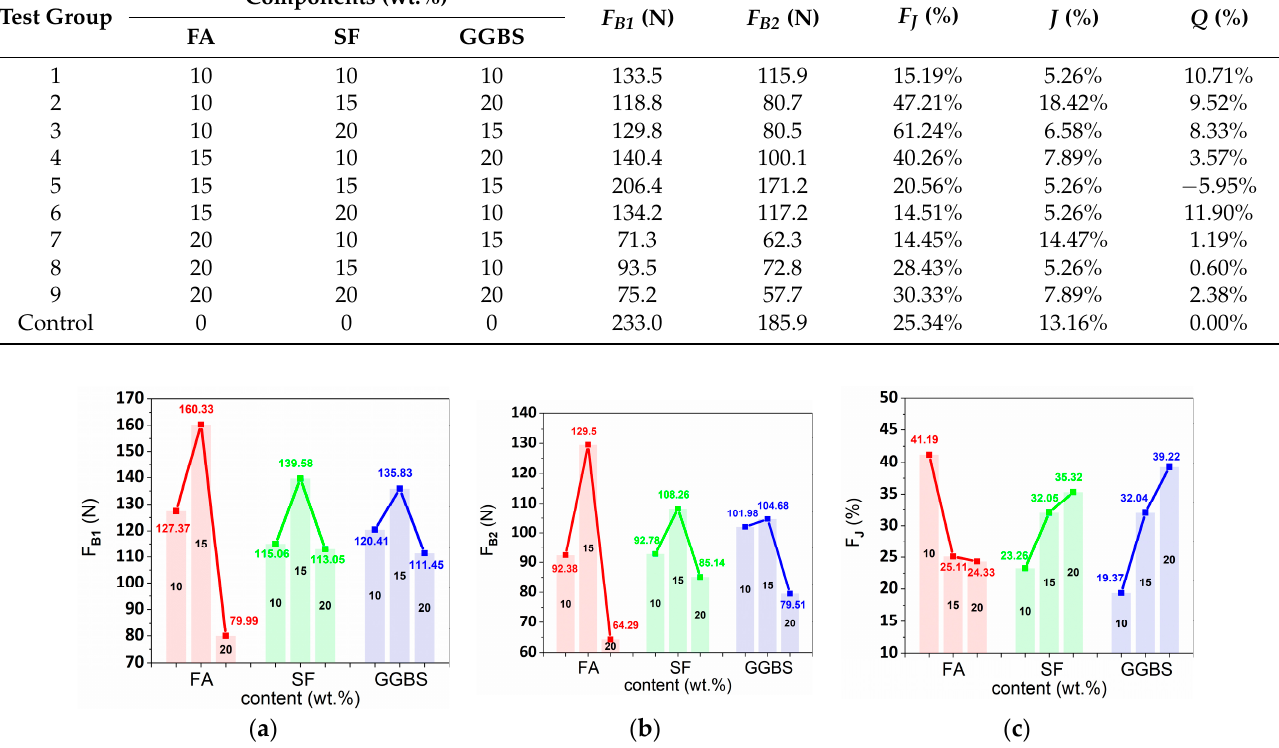
Figure 10. The F B1 ( a ), F B2 ( b ), F J ( c ) average values with the various content (10%, 15%, and 20%) of FA, SF, and GGBS, respectively.